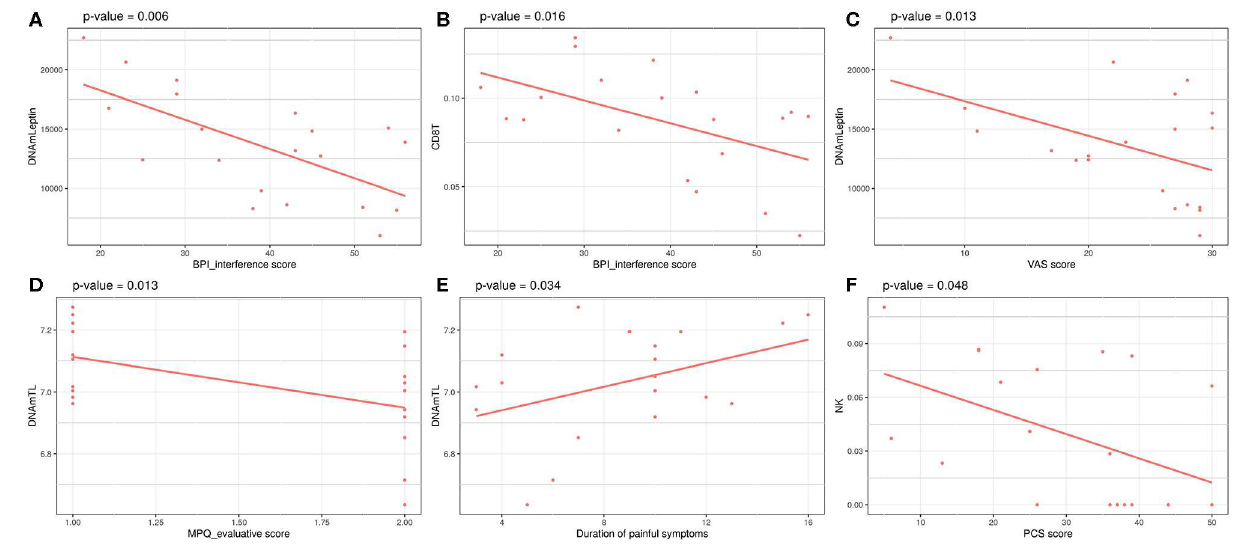
FIGURE 3 | Significant associations between clinical data related to painful phenotype and epigenetic measurements in FM cohort: (A) BPI_interference score vs. DNAmLeptin estimates, (B) VAS score vs. DNAmLeptin estimates, (C) MPQ_evaluative score vs. DNAmTL, (D) BPI_interference score vs. CD8T estimates, (E) Duration of painful symptoms vs. DNAmTL estimates, (F) PCS score vs. NK cells estimates. p- values of a linear model correcting for age are reported.